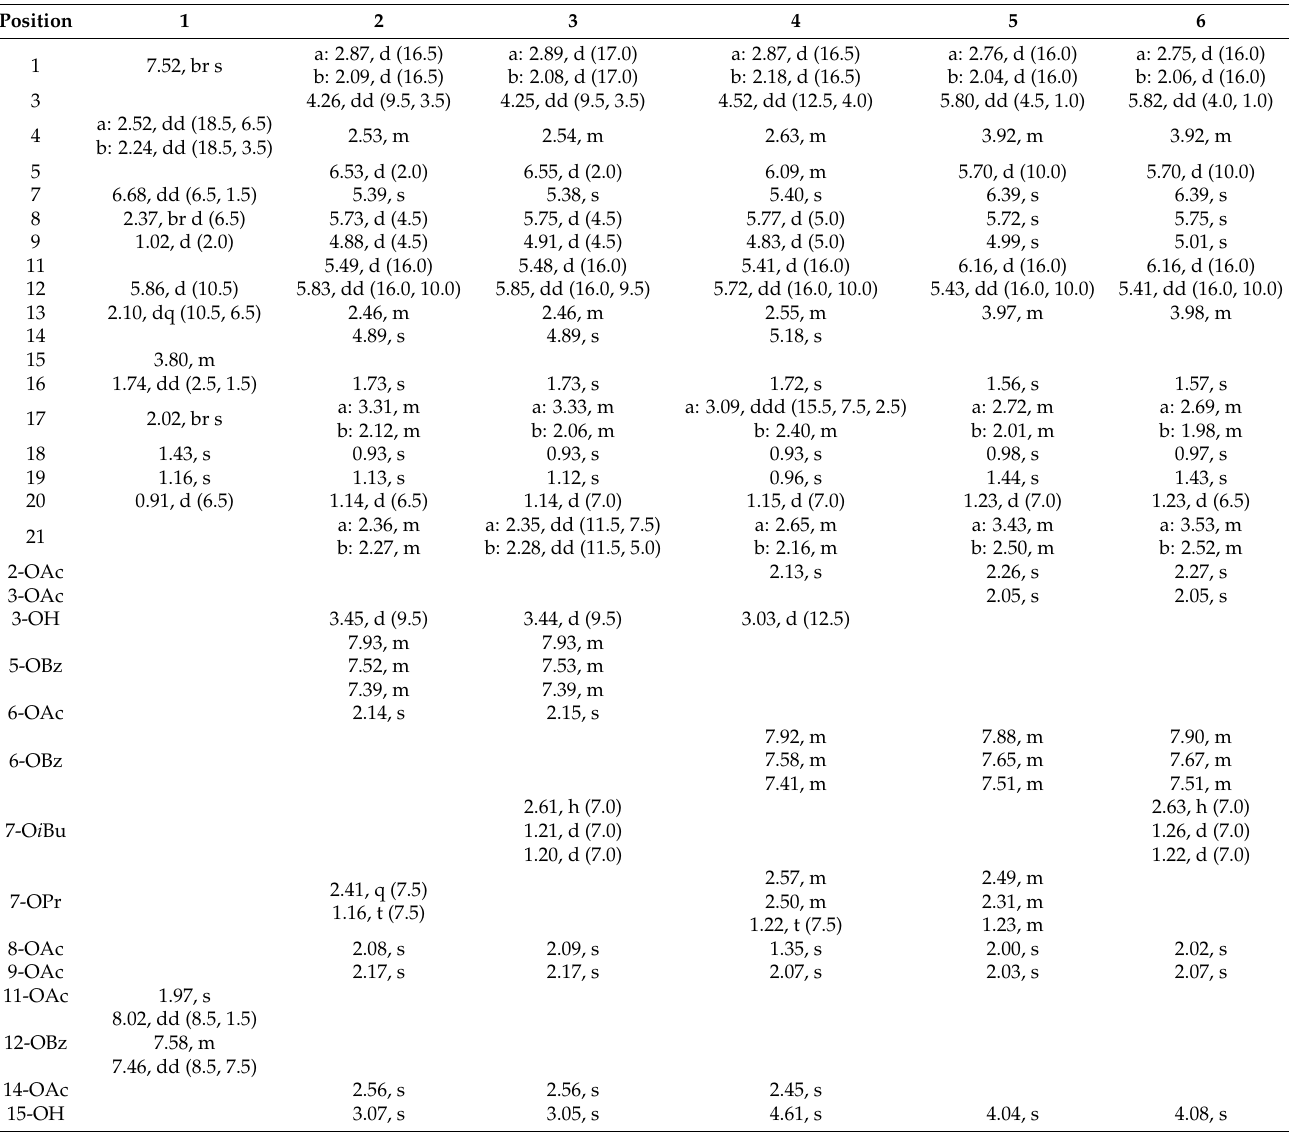
Table 1. 1 H NMR data of compounds 1 – 6 in CDCl 3 at 500 MHz ( δ H in ppm, mult. J in Hz).